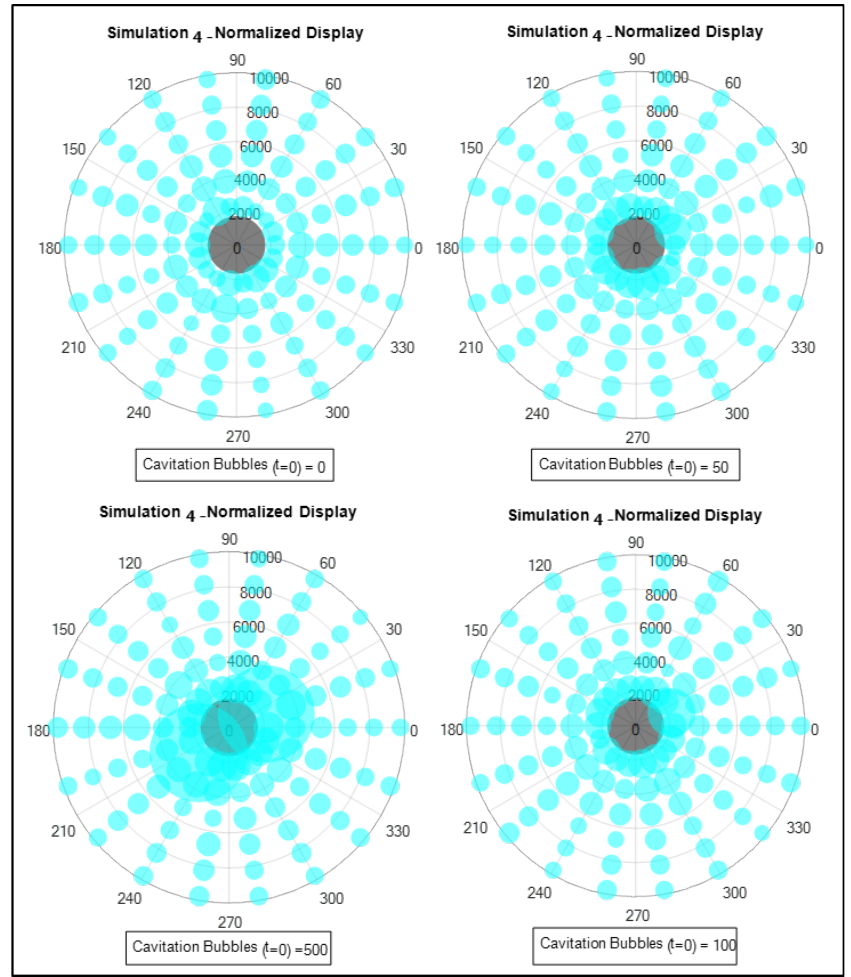
Figure 10. Simulation 4: Normalized display of changes in the initial conditions.